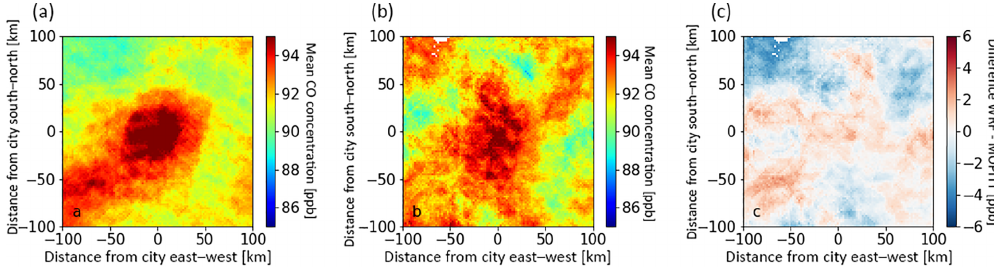
Figure 9. Column average mixing ratios of CO for 2002 before and after emission optimization in WRF: (a) only background optimization, (b) MOPITT V6 signal, (c) difference WRF-MOPITT after background optimization, (d) WRF after background and emission optimization. (e) As (b) . (f) As (c) but now after background and emission optimization. The optimal emission is found to be 0.52 times the original